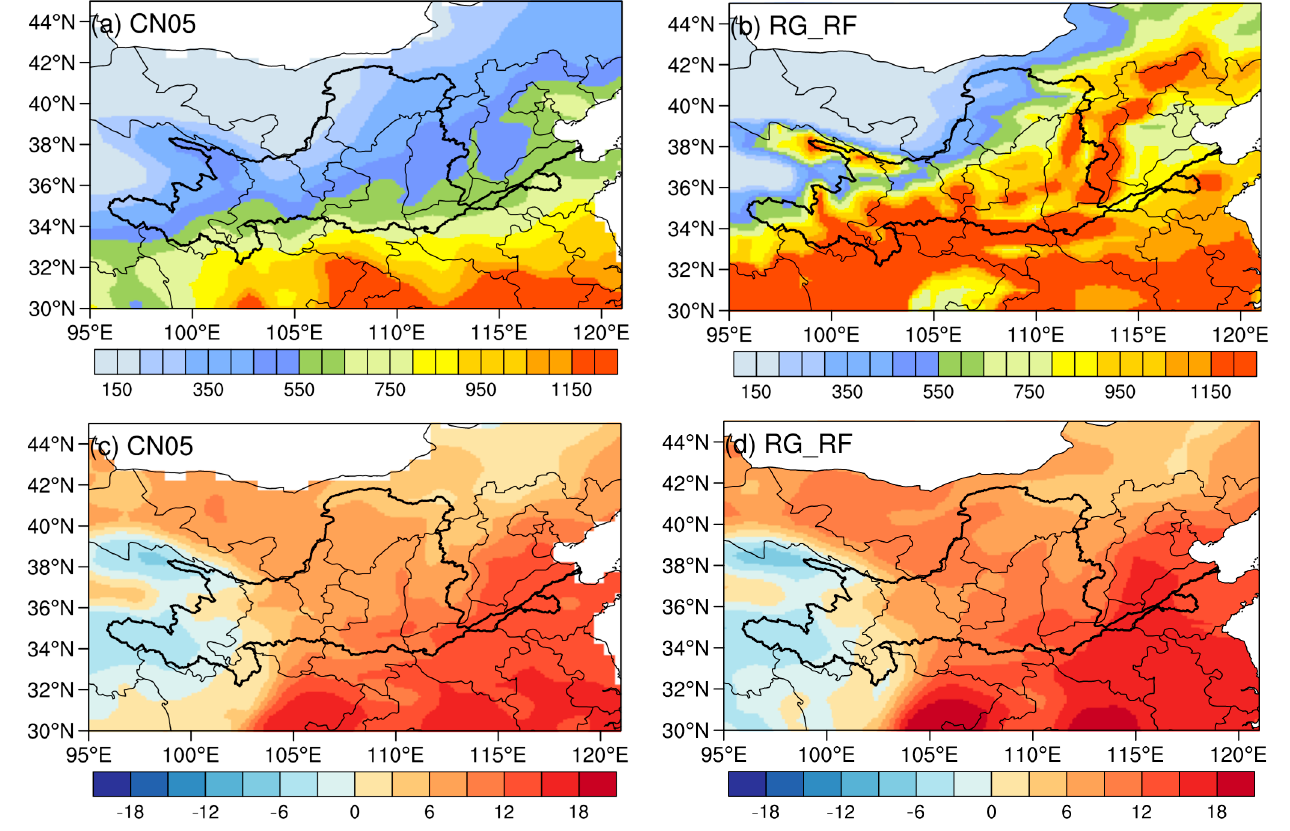
Figure 2. The observed and simulated multi-year average precipitation (( a ): CN05; ( b ): RG_RF) and temperature (( c ): CN05, ( d ): RG_RF) in the YRB. The performance of RegCM4 for air temperature in the region is better than for pre- cipitation. The spatial distribution of temperature simulated by RegCM4 is almost con- sistent with observation, with a 2–3 °C warm bias overall (Figure 2c,d). The observed multi-year average air temperature in China is 6.42 °C and has a spatial correlation coef- ficient of 0.97 between observed and simulated air temperature (Table 3). In the YRB, the observed multi-year average temperature is around 5.69 °C, and the simulated air tem- perature has a spatial correlation of 0.99 with observation. Overall, although there are bi- ases in precipitation and temperature, RegCM4 still has good performance in simulating the climatology of the YRB. The model can accurately capture the main spatiotemporal patterns of the observed precipitation and air temperature. Table 3. Performance parameters of the RegCM4 for precipitation and air temperature in China and the YRB. Precipitation